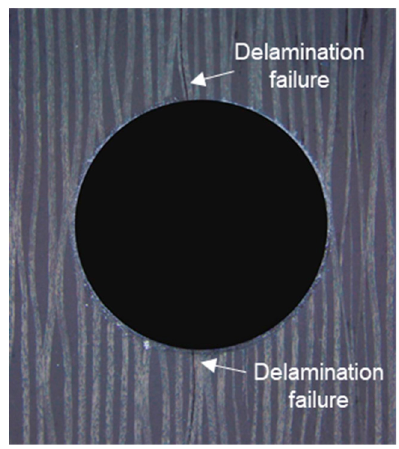
Figure 20. Cross-section image of an OHC ILT fabric specimen showing out-of-plane irregularities and correlation with the location of delamination failure.